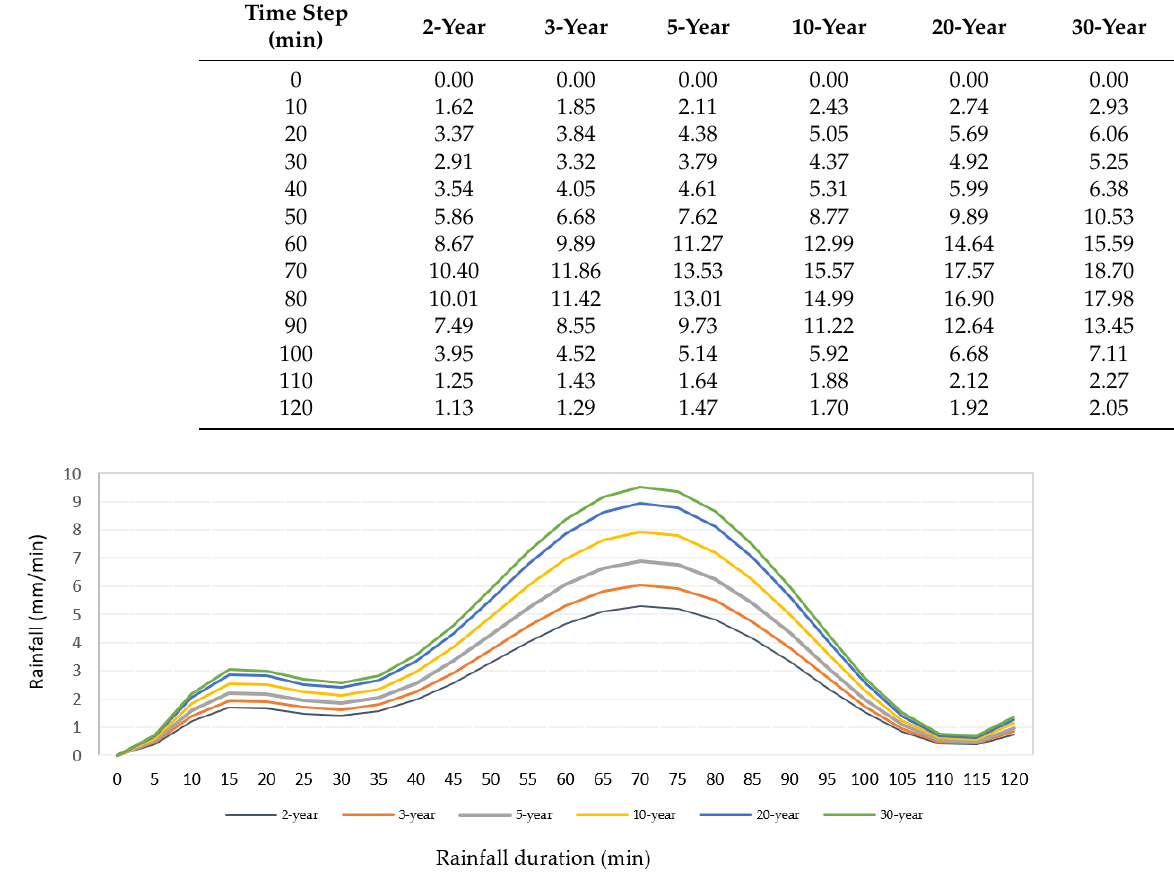
Table 8. Temporal distribution of precipitation for different recurrence periods.